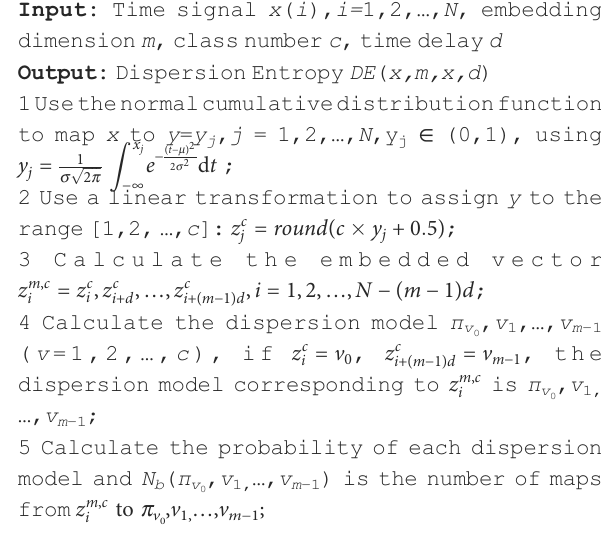
ALGORITHM2 Dispersion Entropy.